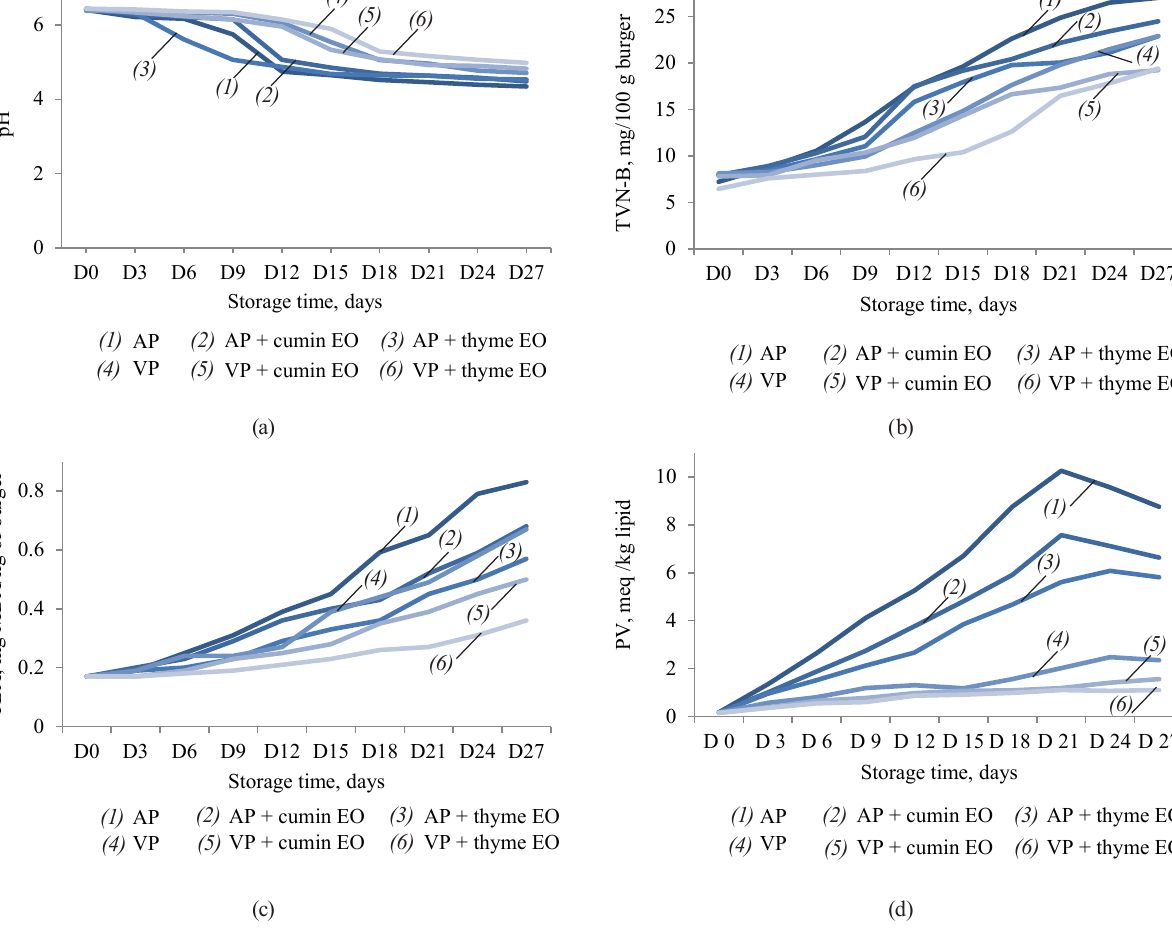
Figure 2 Effects of vacuum packaging (VP) and thyme and cumin essential oils on: (a) pH, (b) TVN-B, (c) TBA, and (d) PV of burgers at